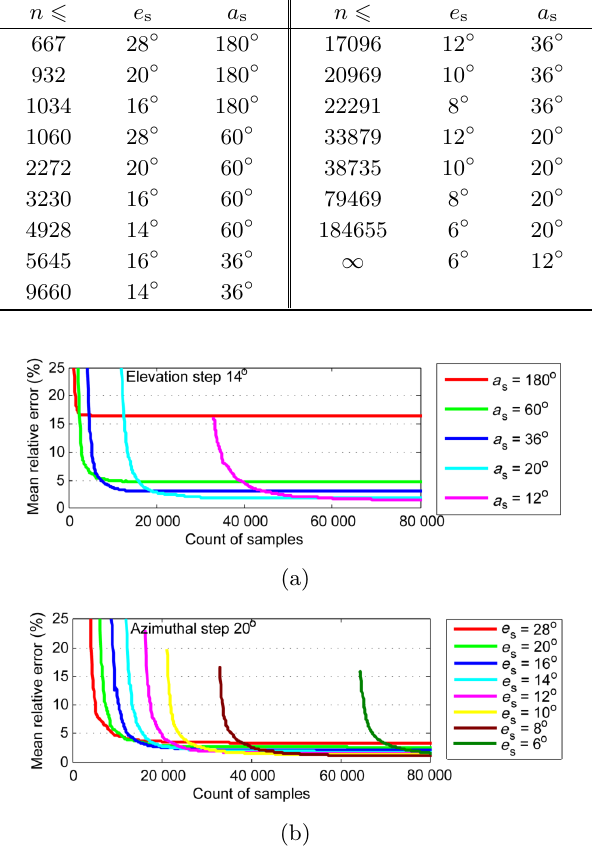
Fig. 6 MRE of the reconstructed BRDF as a function of the number of samples, averaged across all materials (a) for five values of the azimuthal step with a fixed value of e s = 14 ◦ and (b) for eight values of the elevation step with a fixed value of a s = 20 ◦